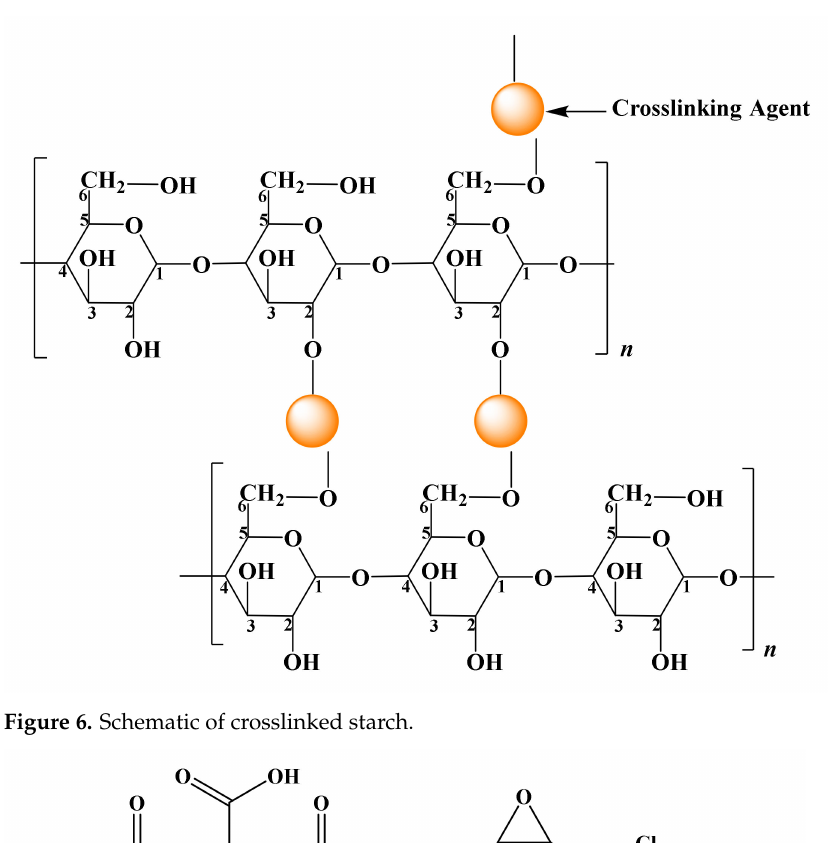
Figure 6. Schematic of crosslinked starch.